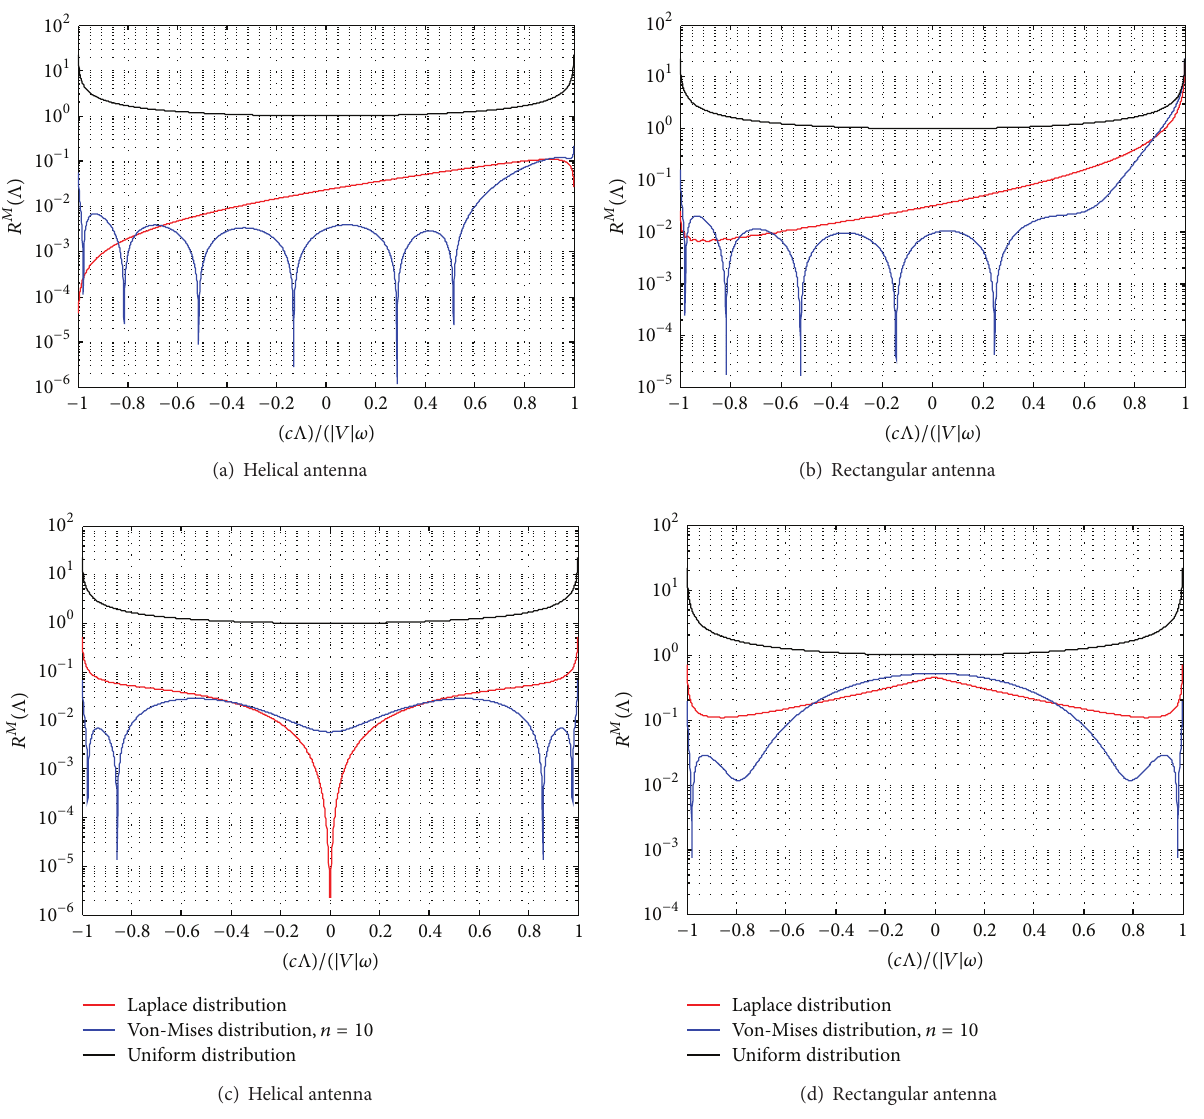
Figure 4: PSD of WB channels, MS moves in the positive direction of the 𝑥 -axis ((a), (b)) and 𝑦 -axis ((c), (d)), two antenna types employed at the MS, nonisotropic propagation (Laplacian or von-Mises distributed), and isotropic environment (uniformly